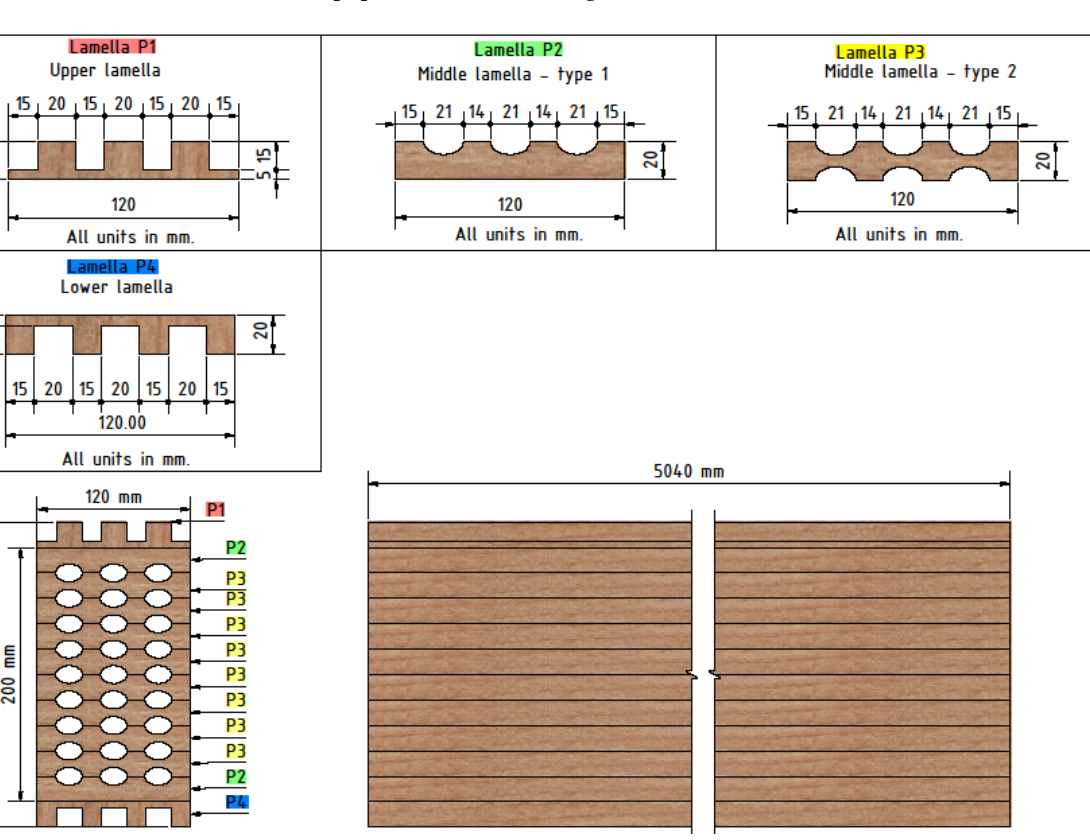
Figure 2. Innovative glue-laminated hollow timber beam.